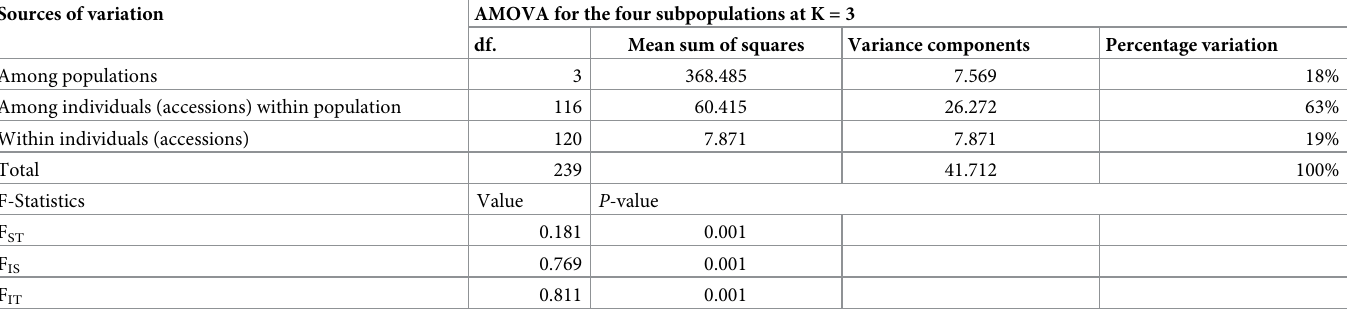
Table 2. Analysis of molecular variance (AMOVA) of the sub-populations present in the panel population at K = 3 for 6 physiological parameters in 120 rice germ- plasm lines.